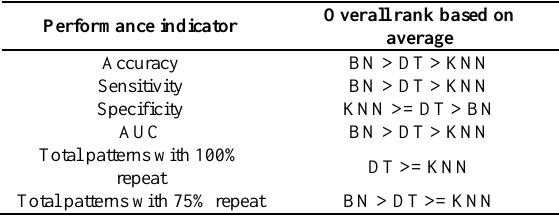
Table 5. Overall rank of mutation technique rank based on average performance.